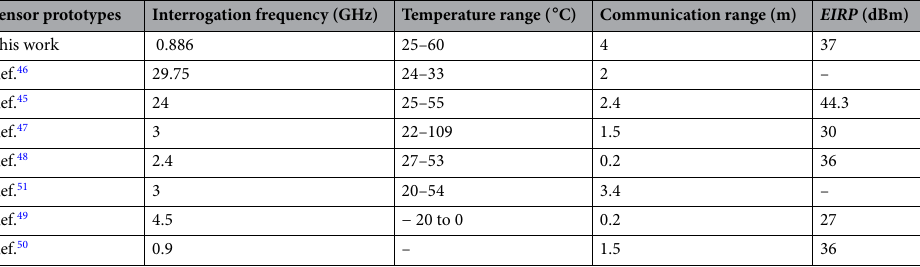
Table 2. Comparison with other chip-less and battery-less tag-based WSNs for temperature sensing. The interrogation frequency, temperature range, communication range and EIRP relative to the reported SubHT are compared to those of other previously developed counterparts tested in uncontrolled (this work and Refs. 45–50 ) or controlled (Ref. 51 ) electromagnetic